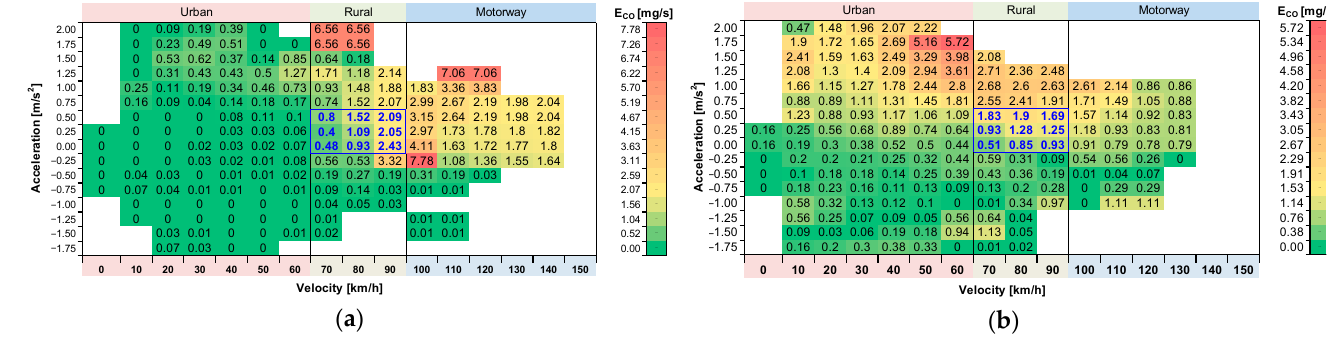
Figure 32. Carbon monoxide (E CO ) emission rate in the RDE test for: ( a ) plug-in; ( b ) HEV. The NO x emission rate characteristics are also different for the plug-in vehicle and the HEV. For the plug-in vehicle, there is a reduced NO x emission rate mainly in the urban and rural part (Figure 33a). However, in the motorway part, it is higher (0.3–0.4 mg/s) than for the HEV vehicle (0.2–0.3 mg/s).